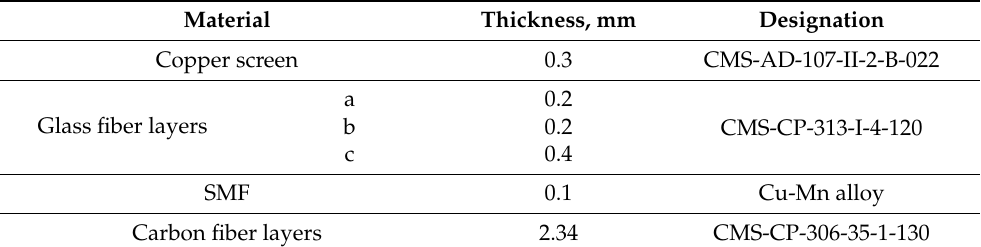
Table 1. Material specification.